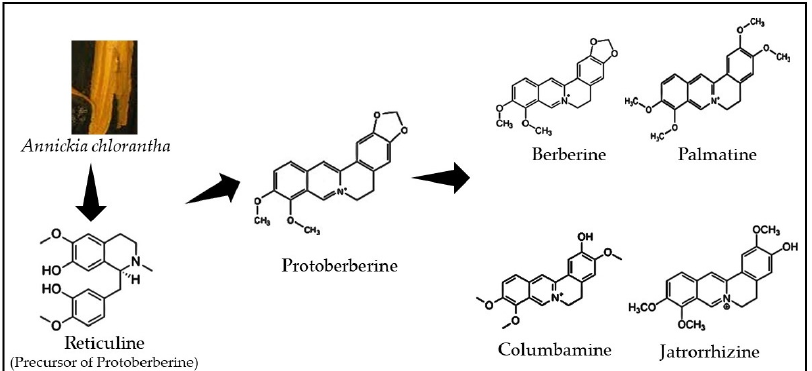
Figure 1. Chemical structures of protoberberine alkaloids class.